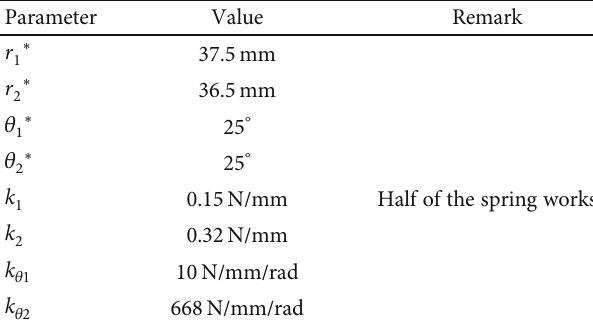
Figure 10: Force analysis of the spine anchoring system.